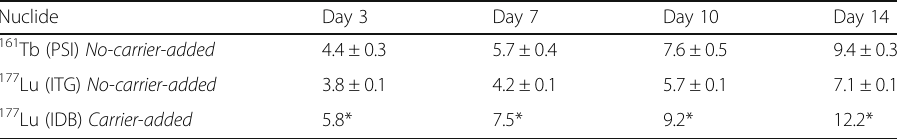
Table 4 DOTA-to-nuclide molar ratios, corresponding to 50% labeling efficiency of 161 Tb-DOTA and both carrier-added and no-carrier-added 177 Lu-DOTA over a two-week decay period